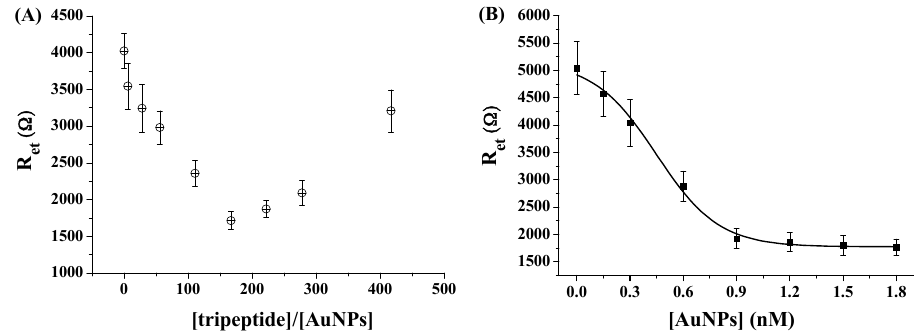
Figure 5. ( A ) Dependence of R et on the concentration ratio of the tripeptide to AuNPs. The final concentration of AuNPs was 1.8 nM and that of the peptide varied from 0 to 0.75 μ M (0, 0.01, 0.05, 0.1, 0.2, 0.3, 0.4, 0.5 and 0.75 μ M); ( B ) Dependence of R et on the AuNPs concentration. The concentration ratio of the tripeptide to AuNPs kept at 167.